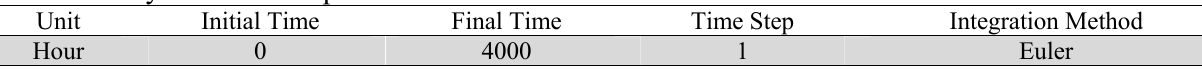
The summary of VENSIM parameters